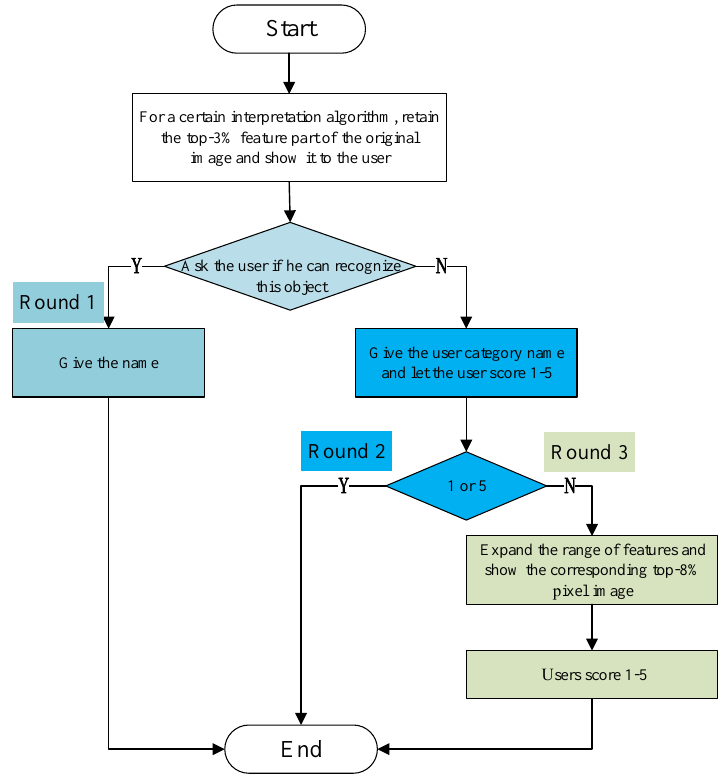
Figure 8. Flow chart of user persuasion method with three rounds (round1, round2 and round3), different colors indicate different round